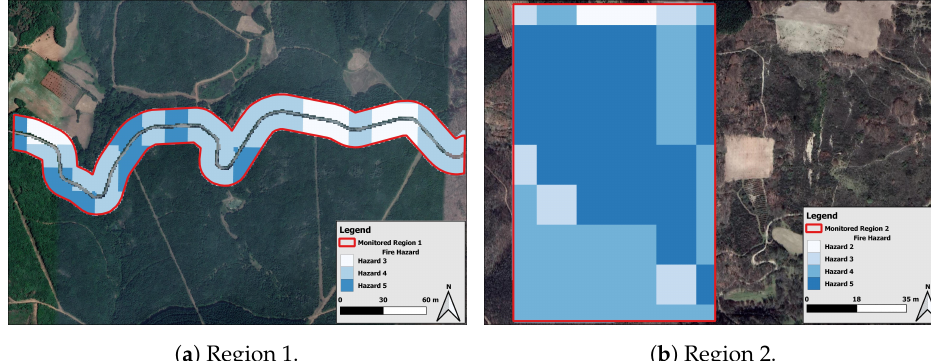
Figure 2. Fire hazard maps of the forest regions.